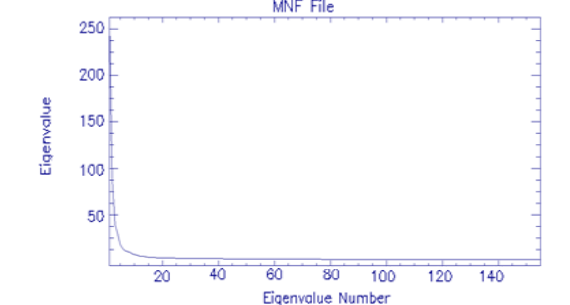
Figure 9. Correlations between eigenvalues and eigenvalue numbers using MNF transformation